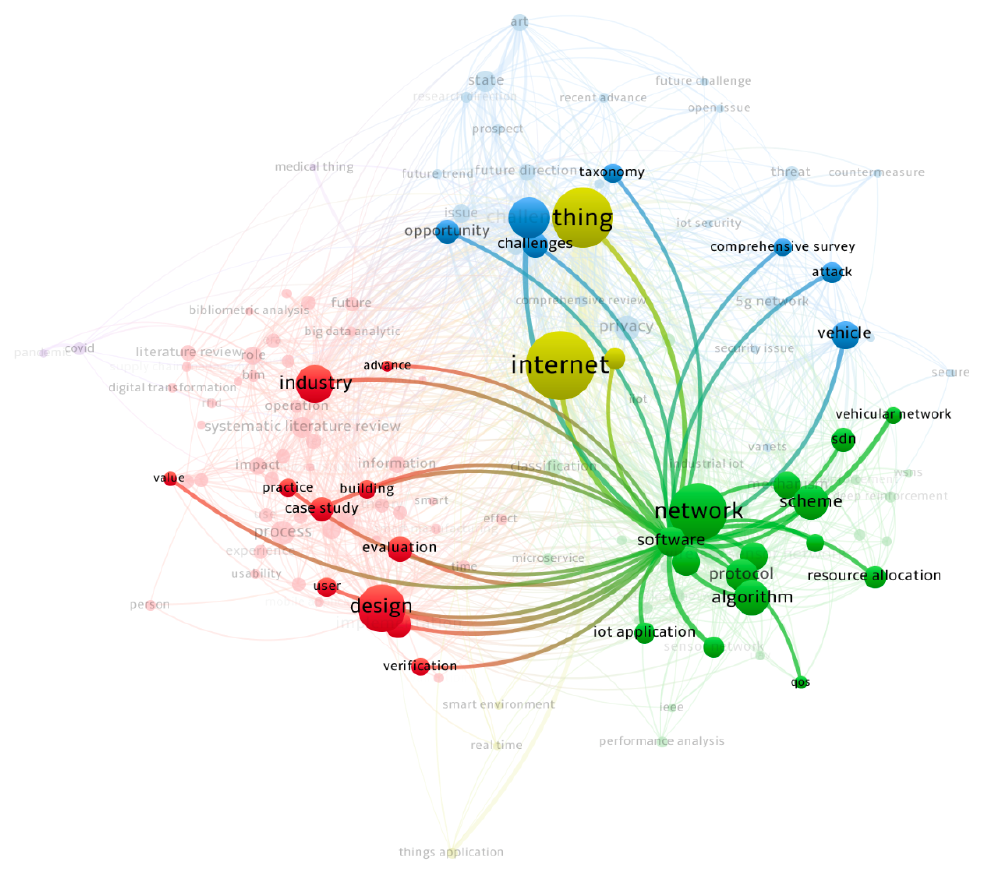
Figure 3. Bibliometric visualization of the primary